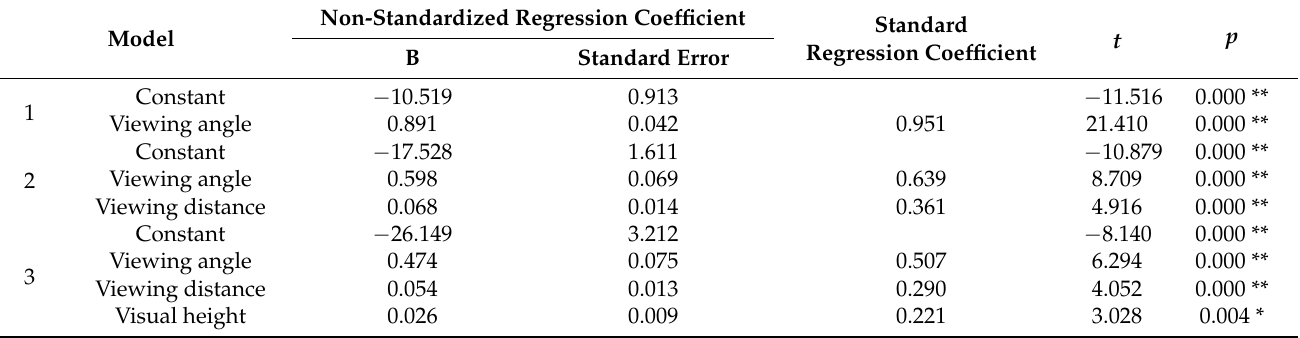
Table 4. Multivariate standard regression analysis of BF and different human–machine viewing